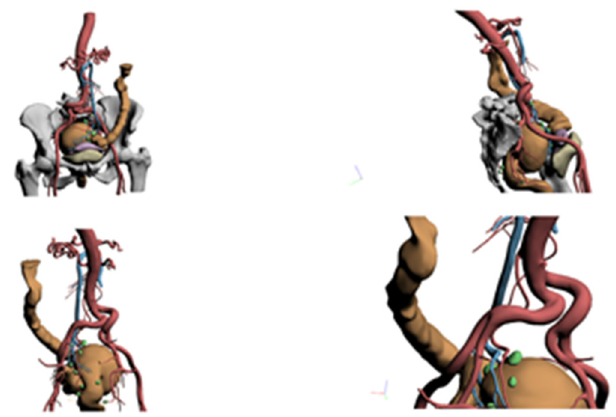
Figure 6. 3D reconstruction (Case 2).